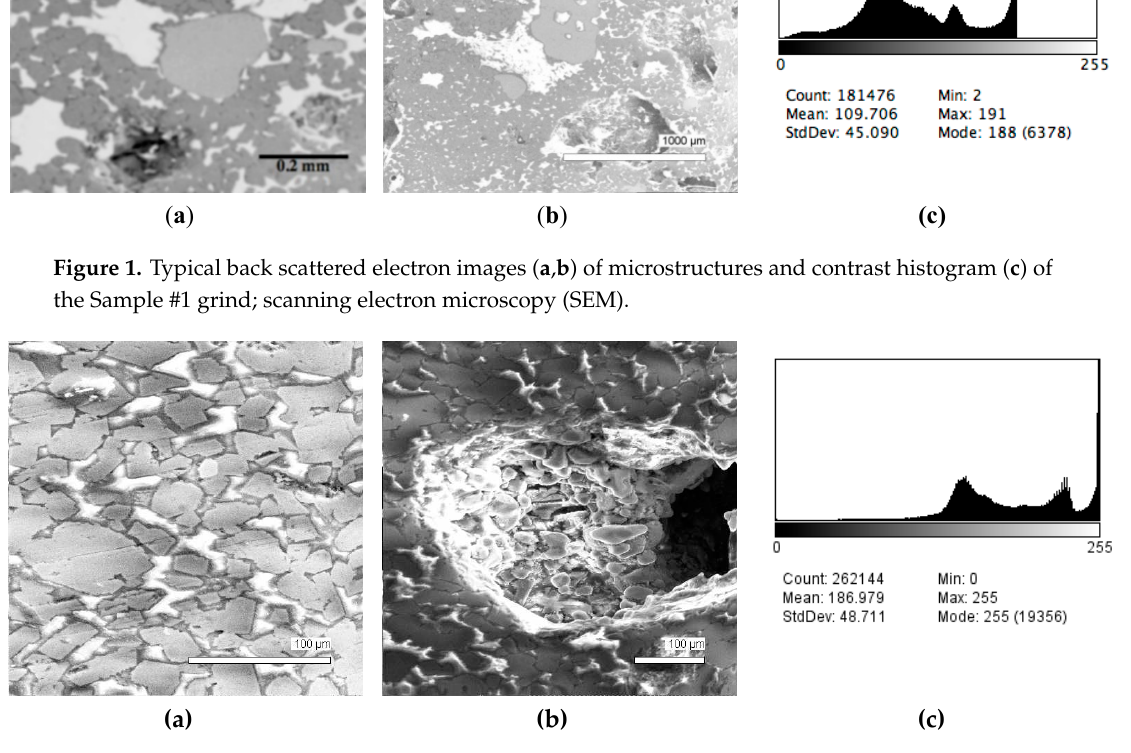
Figure 2. Typical back scattered electron images ( a , b ) of microstructures and contrast histogram ( c ) of the Sample #2 grind; SEM.